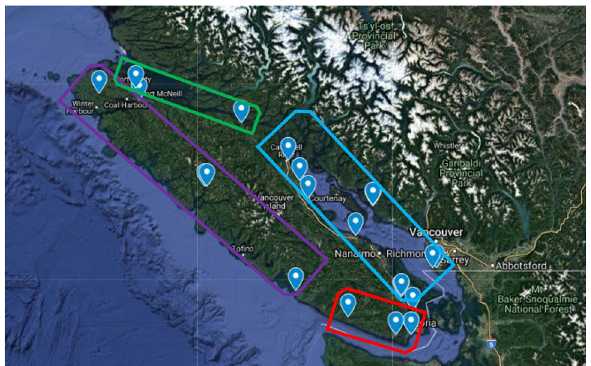
Figure 1. Map of the locations of our sites sampled on the Southern Mainland coast of BC and around Vancouver Island, BC. The Strait of Georgia is in the blue rectangle. The Juan de Fuca Strait is in the yellow rectangle and both Straits make up the Salish Sea. The western coast of Vancouver Island is in the purple, and the northern coast is in the green rectangle. Two points on this map are four separate sites (Moutcha Bay and the site on the Sunshine Coast). The sites were in close proximity on the map, they look like a single point on the map. All latitudinal and longitudinal coordinates can be found above in Table S1. Most sites can be accessed by paved road, but 4 sites were accessed along active logging roads (Bamfield South Inlet, Moutcha Bay (2 Sites), and Holberg, BC). Experience driving on logging roads is crucial. The base map was constructed using Google Earth (open access) at https:// earth. google. com/